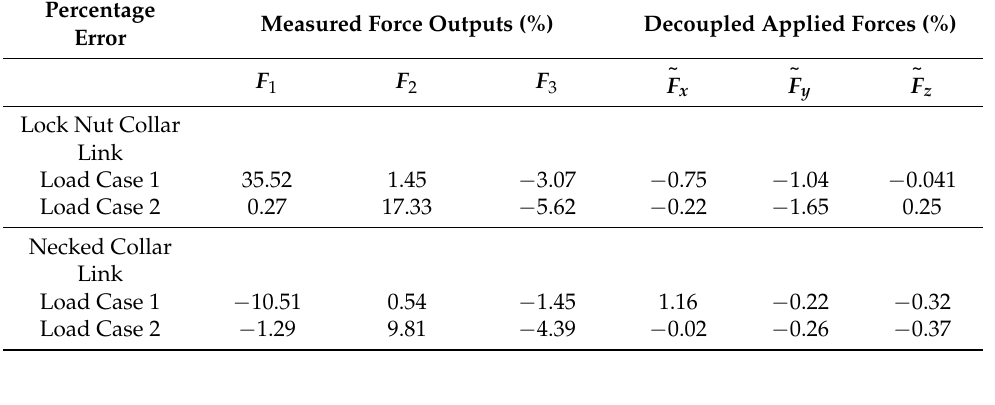
Table 2. Percentage error of the measured forces and decoupled forces for simultaneous loading experiment.